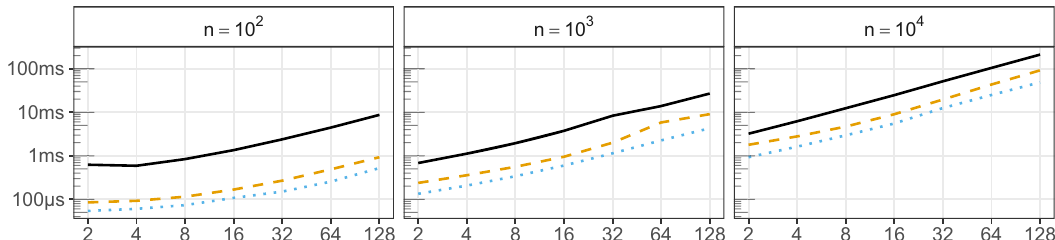
Figure 8: The median runtime of the MDCM ( solid, black ) and LFM algorithms ( dashed, yellow ) for the extMO distribution with a pure - drift subordinator ( independence case ) . We included the optimized ESM algorithm for the Armageddon family ( dotted, blue ) as a reference. It hints at the costs of the sorting operation of the LFM algorithm, which is super fl uous for a pure - drift